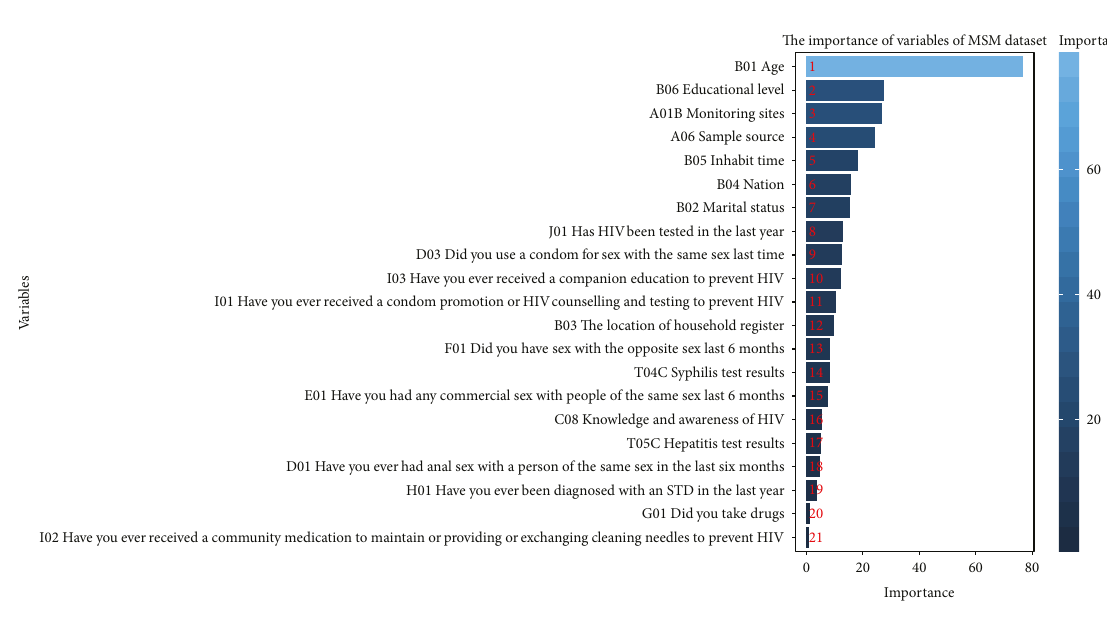
Figure 1: The importance of variables of MSM dataset.